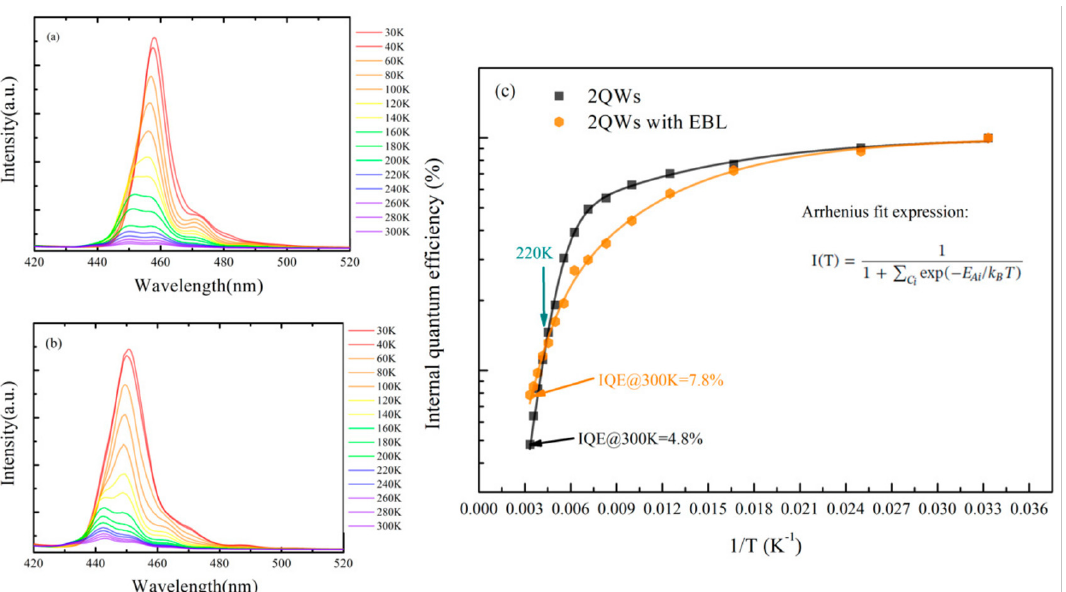
Figure 5. The TDPL spectra from 30 to 300 K for sample 2QW ( a ) and 2QWEBL ( b ); the trend of internal quantum efficiency with increasing temperature from 30 to 300 K ( c ); the lines are correspond- ing to the Arrhenius fitting. The IQE is derived by calculated the ratio of integrated luminescence intensity at room temperature and that at low temperature (here is 30 K).